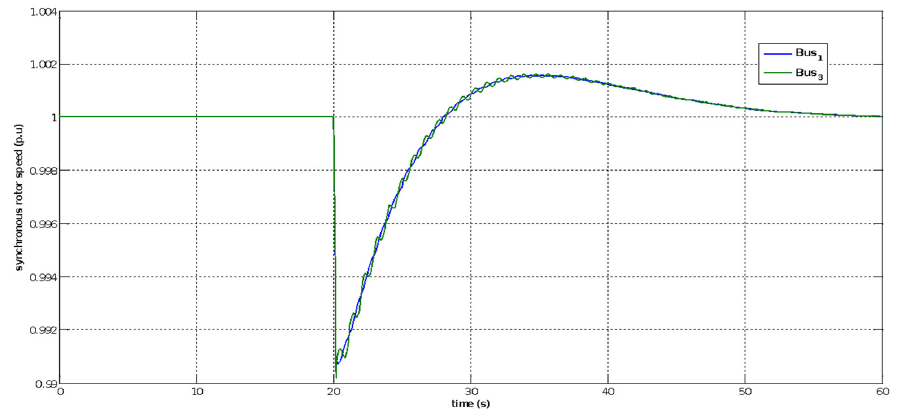
Figure 39. Rotor speed response of generator at swing bus 1 and bus 3 under a three-phase short circuit at bus 15 without STATCOM.